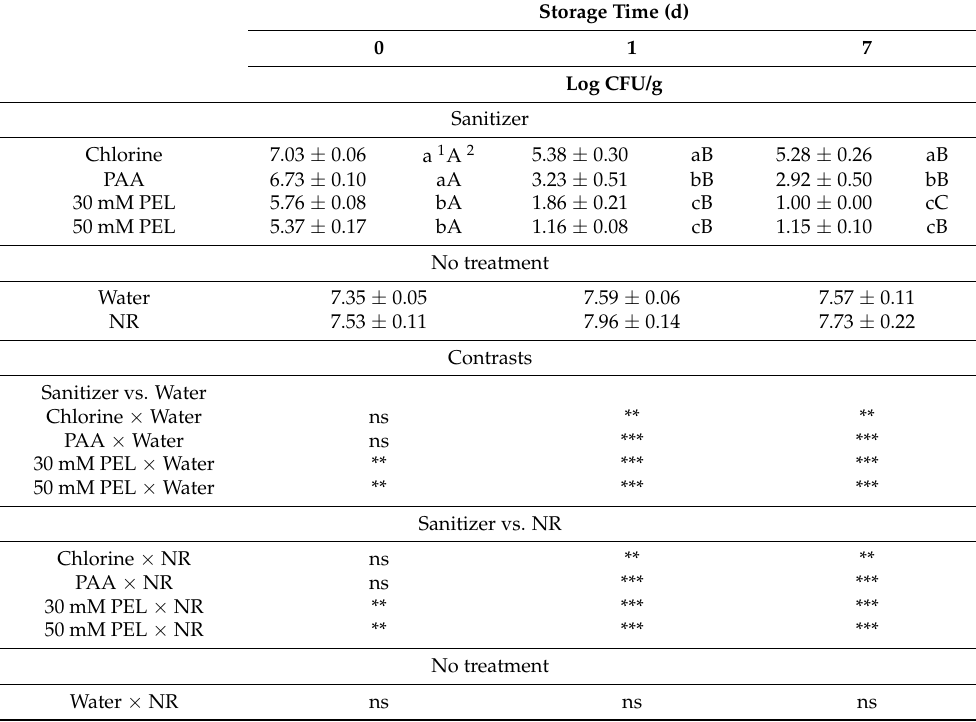
Table 2. Log populations (CFU/g) of Salmonella enterica on the inoculated tomato surface immediately after sanitizer treatment (0 d) and throughout 1 d and 7 d storage at 8 ◦ C. There were no significant third and second order interactions among organic load (OL), sanitizer and storage duration treat- ments, so OL and non-OL sanitizer data were analyzed and reported together (sanitizer n = 16; no treatment n =